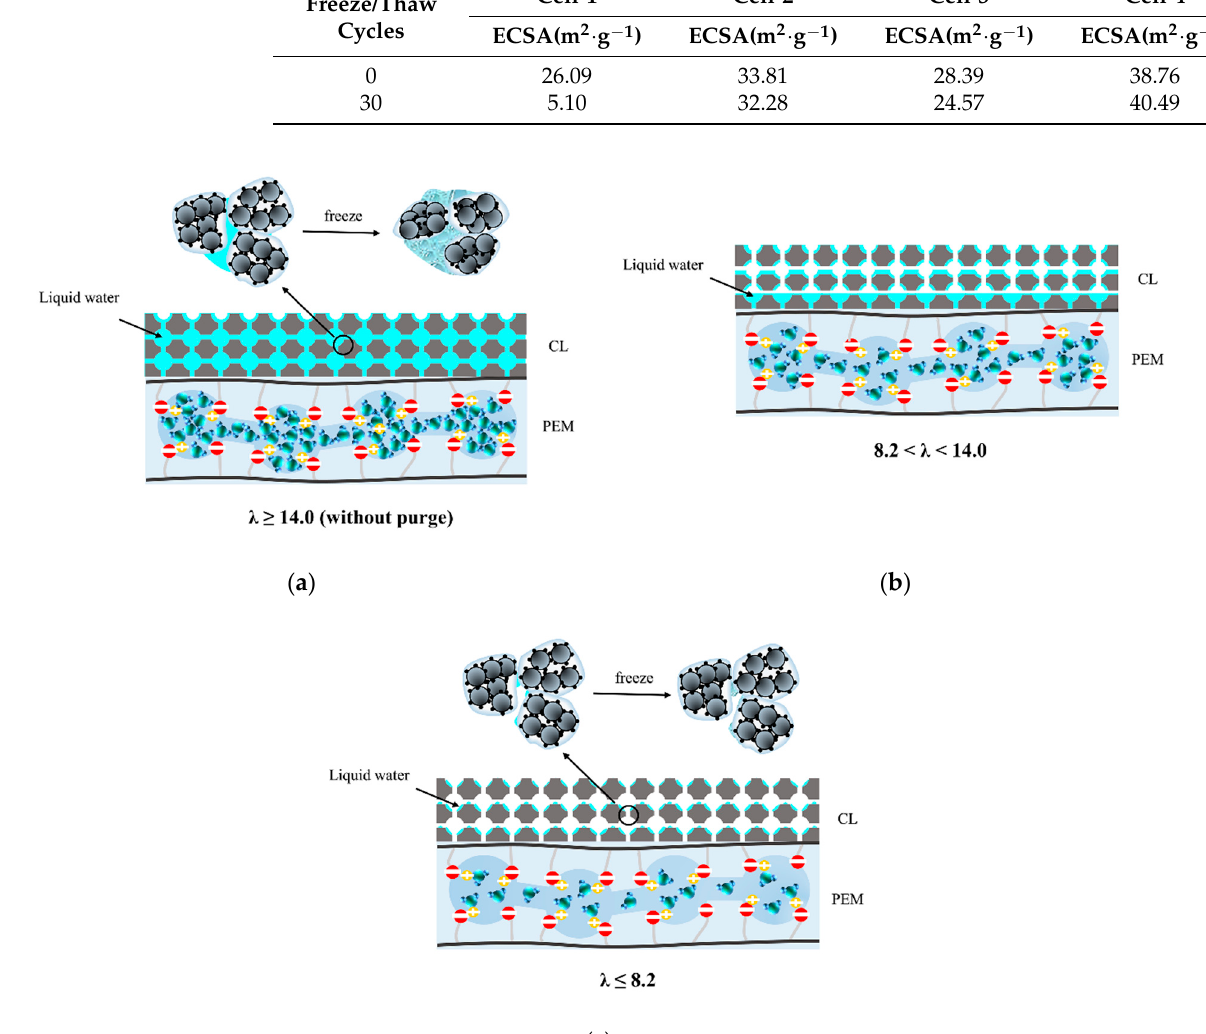
Figure 6. Schematic description of water distribution in membrane and catalyst layer: ( a ) λ ≥ 14.0; ( b ) 8.2 < λ < 14.0; ( c ) λ ≤ 8.2.